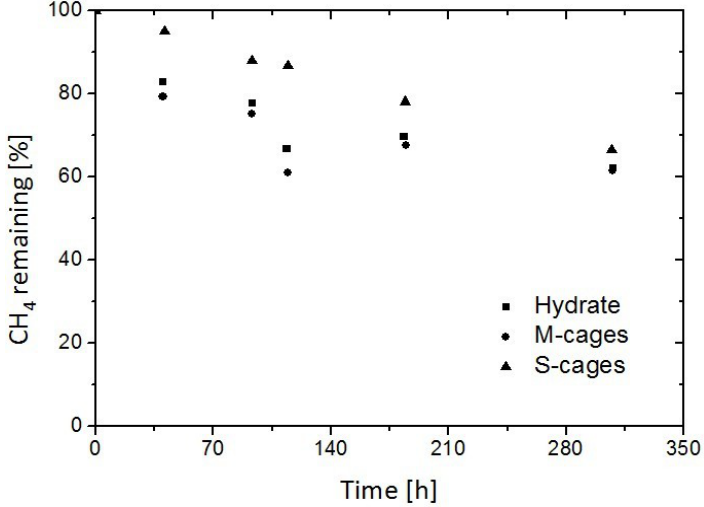
in the M-cages, S-cages and 4